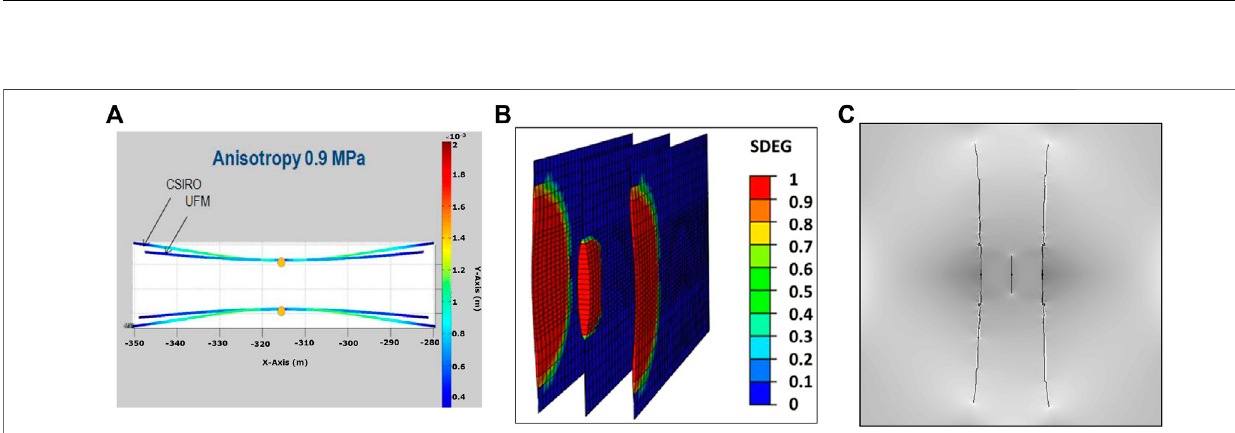
FIGURE 6 | Numerically obtained stress interference of hydraulic fractures from horizontal wells in previous studies. (A) Geometry of parallel fractures in anisotrophic stress fi elds by Kresse et al. (2013). (B) Fracture geometry with a fracture spacing of 20.0 m by Guo et al. (2015) and (C) shows the geometry of three hydraulic fractures with 3.0 m spacing by Li et al.